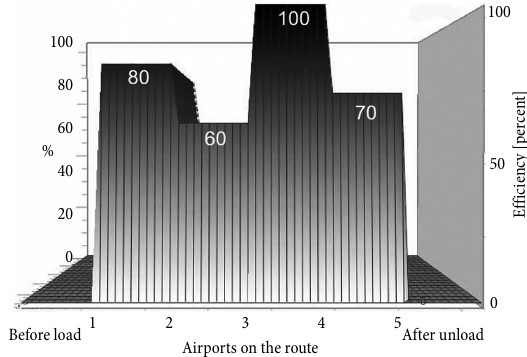
Before Fig. 9. Efficiency of airplane capacity on the route